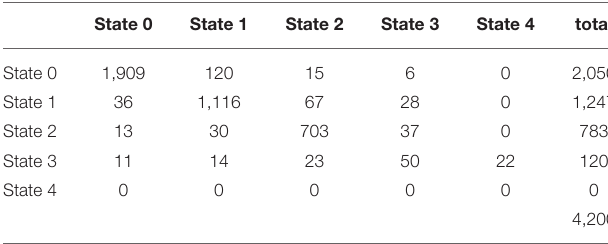
TABLE 2 | Observed transition counts of the patients over the 29